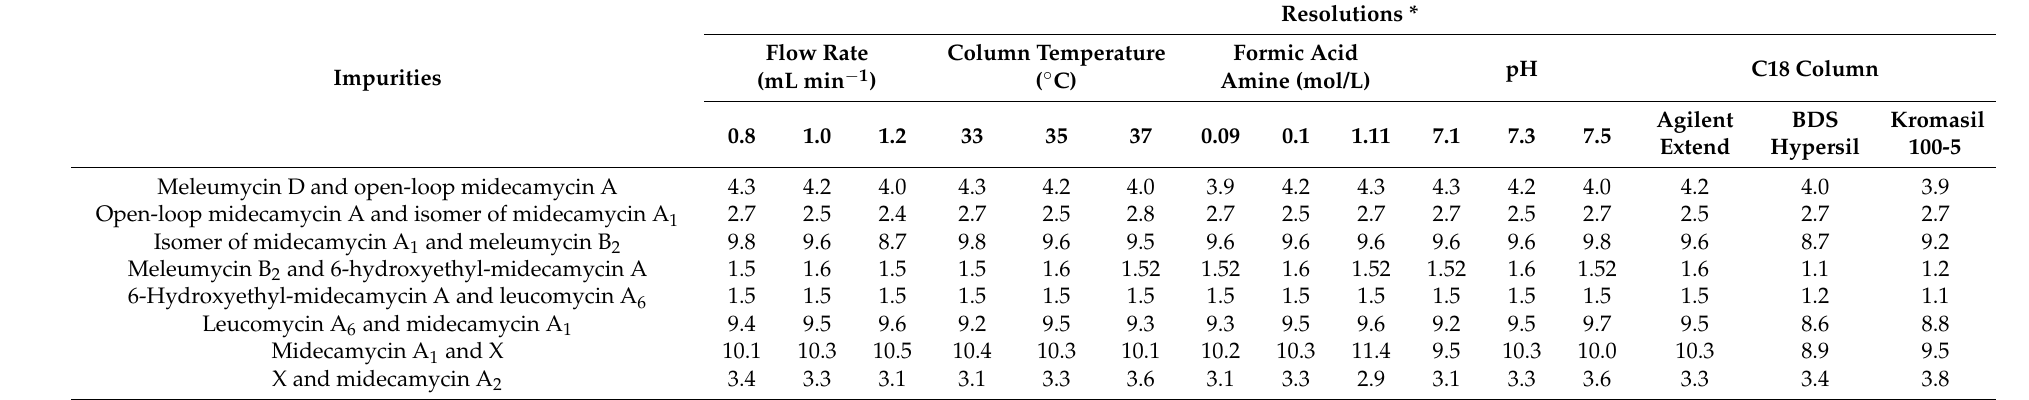
Table 4. The robustness data under various conditions for the HPLC separation of the